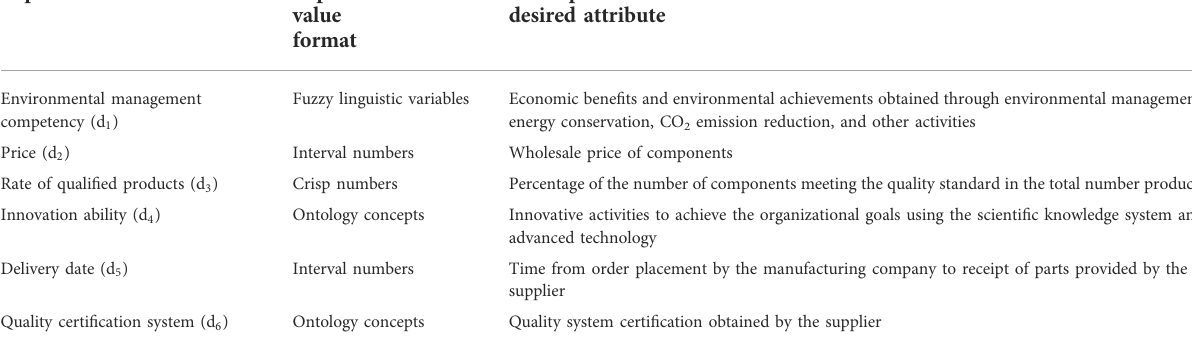
TABLE 11 Expected attributes and related